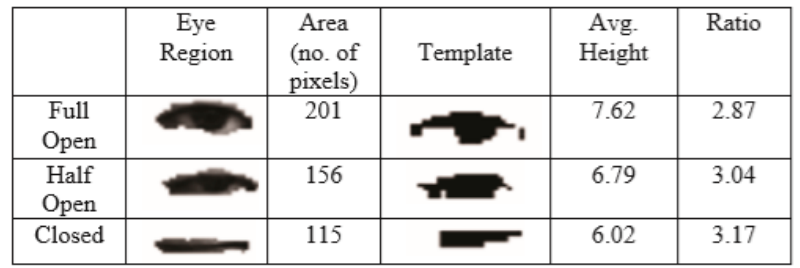
Figure 3. Example of eye-opening ratio calculation.